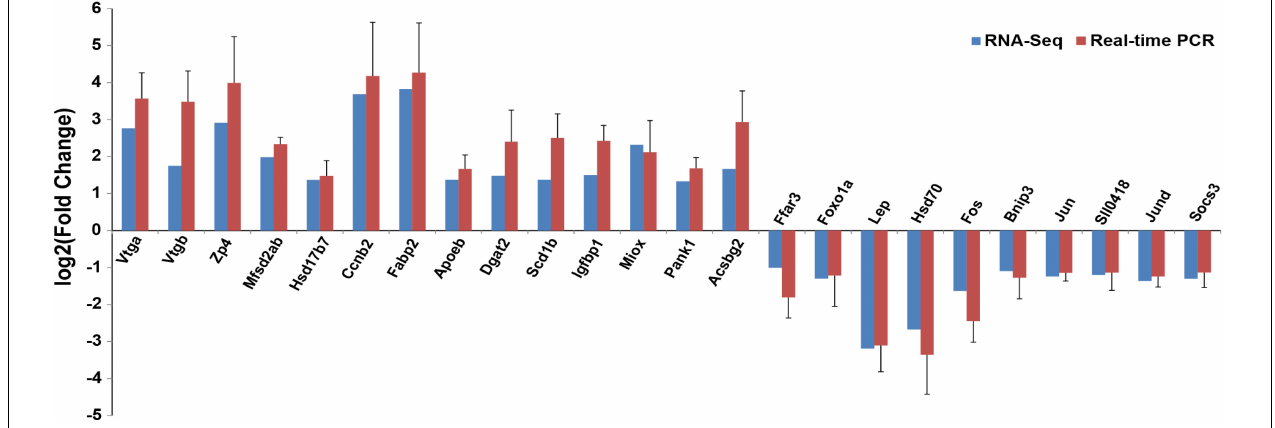
FIGURE 4 | Comparison of gene expression data between RNA-seq and real-time PCR (means ± SE).